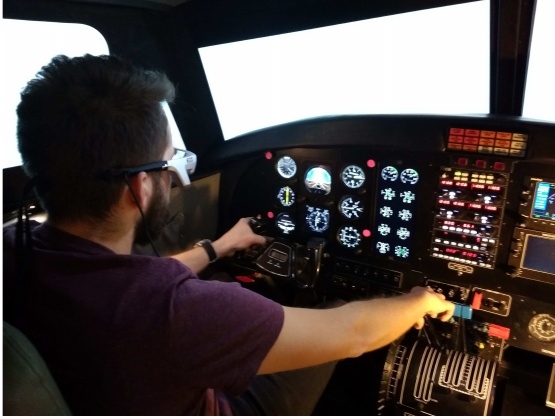
Figure 3. Test stand, with introduced markers, used for the pilot’s attention